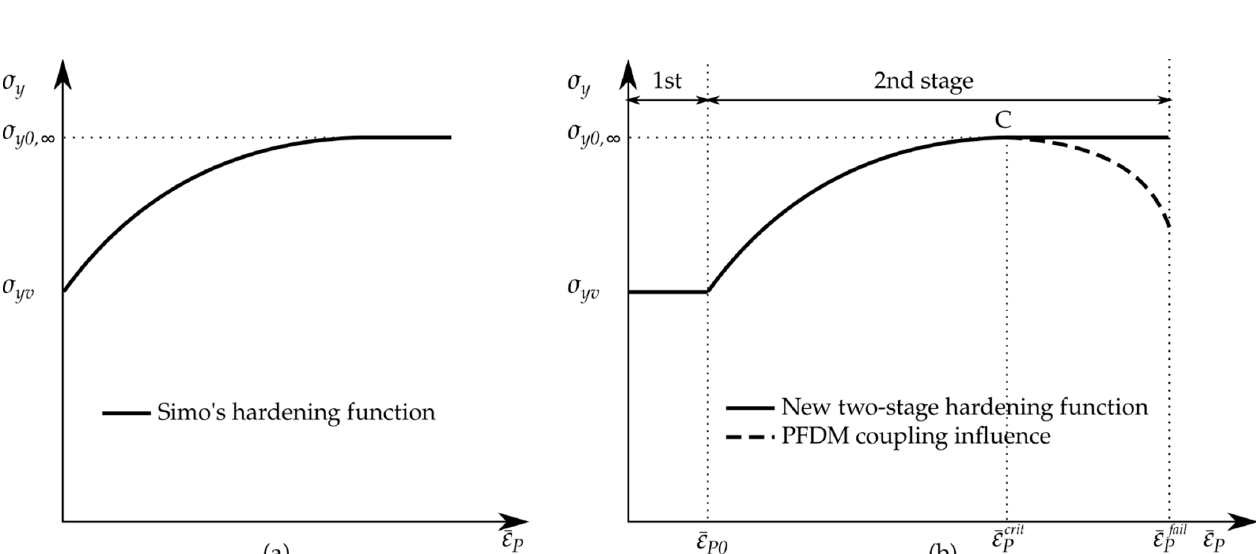
σ vs. equivalent plastic strain ε diagram for metallic materials: ( a ) the y P σ —the initial yield stress, σ ∞ —the saturation hard- yv 0, y —the critical equivalent plastic strain, ε fail —the P P